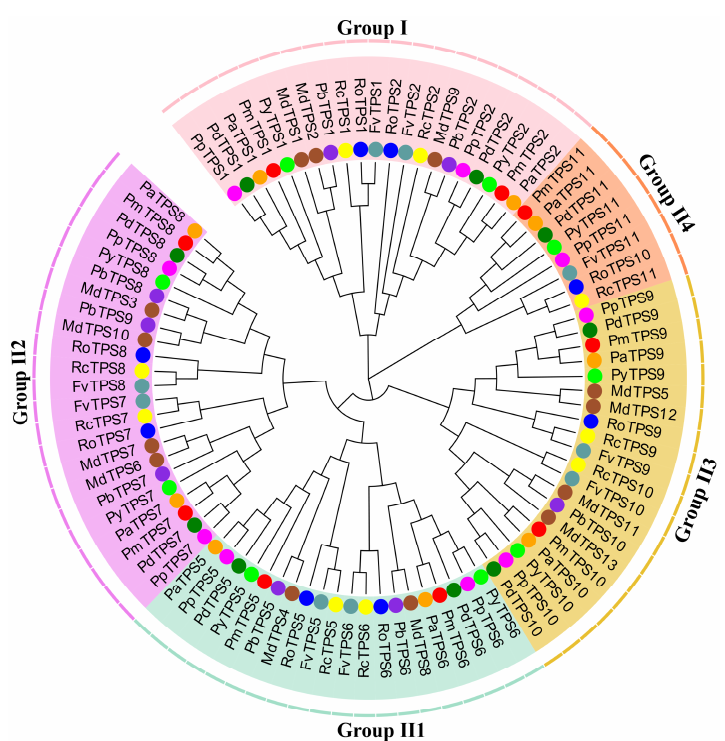
Figure 7. The phylogenetic tree of TPS family members from Prunus mume (PmTPS), P. persica (PpTPS), P. yedoensis (PyTPS), P. armeniaca (PaTPS), Fragaria vesca (FvTPS), Malus domestica (MdTPS), P. dulcis (PdTPS), Pyrus bretschneideri (PbTPS), Rosa chinensis (RcTPS), and Rubus occidentalis (RoTPS). The pink, #A3DFC8, violet, #E9C031, and #FF8E54 colored regions represent Groups I, II1, II2, II3, and II4, respectively. TPSs from 10 Rosaceae species are labeled by circles of red, fuchsia, lime, coral, cadet blue, sienna, green, blue violet, yellow, and blue colors, respectively. All of the referred TPS genes are listed in Table S3. Table 1. Detection selective pressure of the TPS family under site